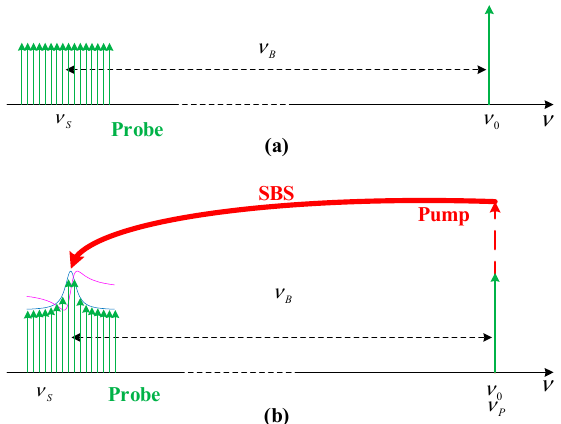
Figure 2. The OFC-based fast BOTDA scheme. ( a ) Frequency component distribution of the OFC-probe wave and ( b ) the frequency component distribution of the OFC-probe wave and pump pulse under the SBS effect.